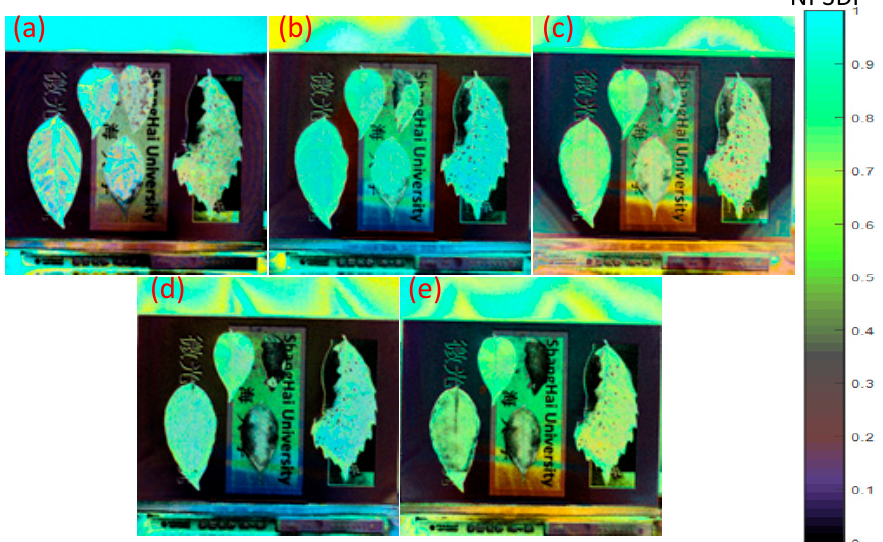
Figure 11. The fusion image in a time series. Illumination of the NDAI: ( a ) 0.01 lux, ( b ) 0.1 lux, ( c ) 0.5 lux, ( d ) 1.0 lux and ( e ) 5.0 lux.